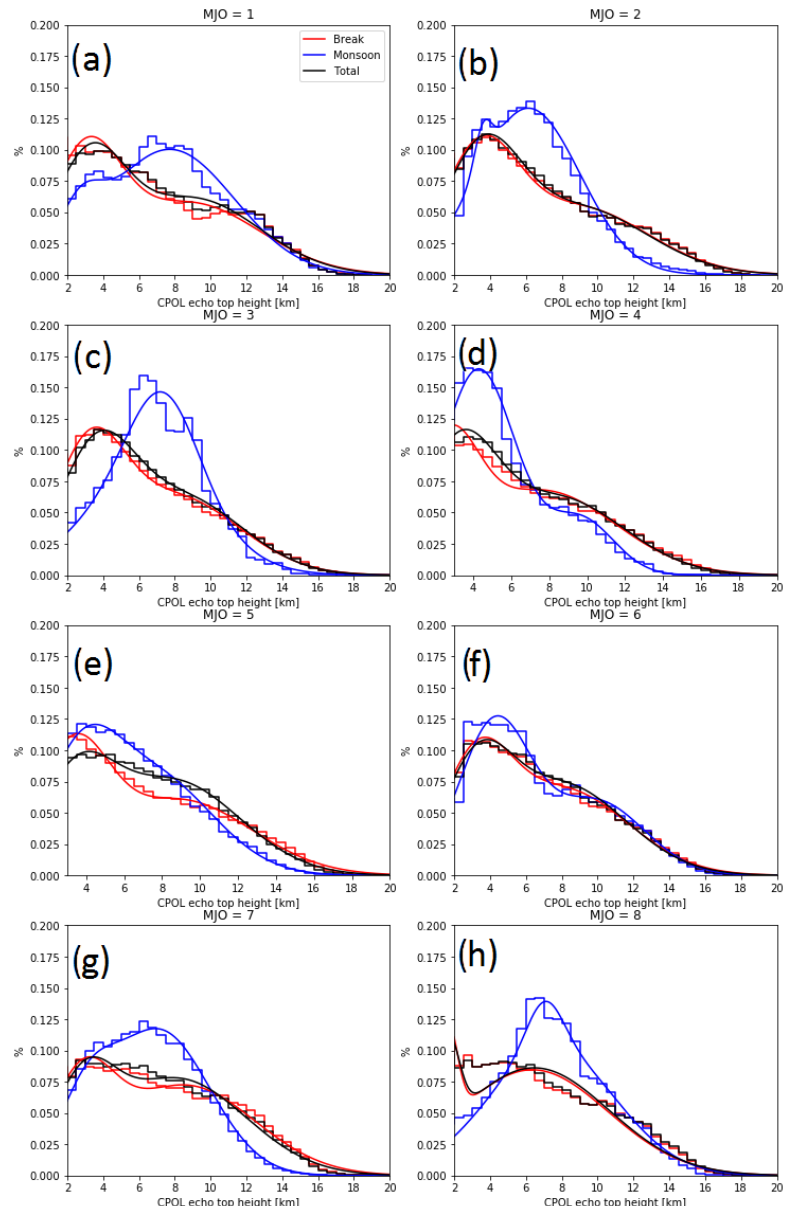
Figure 7. normalized frequency distribution of ETHs in convective regions as a function of MJO index for break and monsoon conditions. (a–h) each represent a different MJO index. Solid lines represent medians of modes derived from the fit of the bimodal Gaussian probability density function (p.d.f.) to the normalized frequency